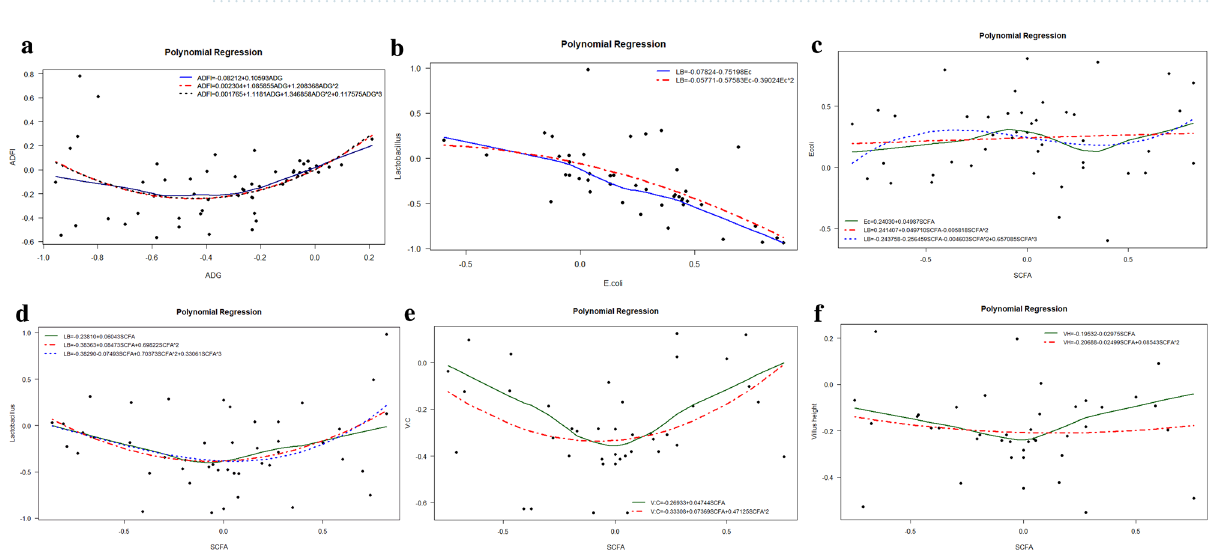
Figure 3. Density plot. ( a ) Density plot of ADFI and ADG data. ( b ) Density plot of fatty acids. (c) Density plot of microbes.